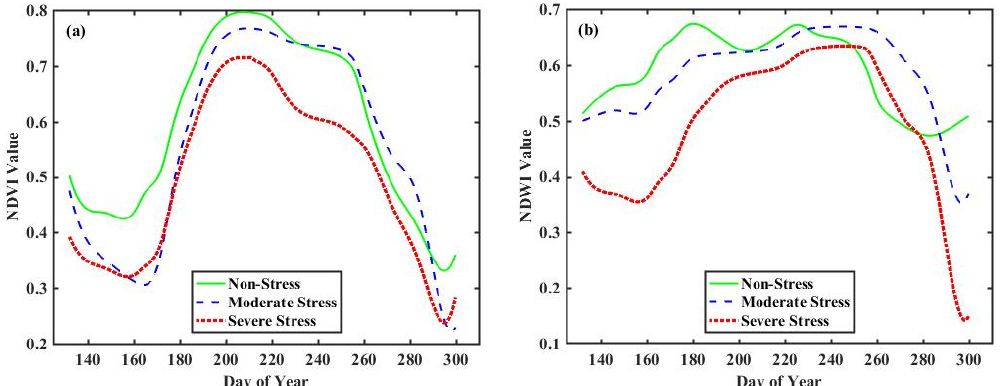
Figure 4. Schematic diagram of changes in ( a ) greenness and ( b ) moisture under different heavy metal stress levels.